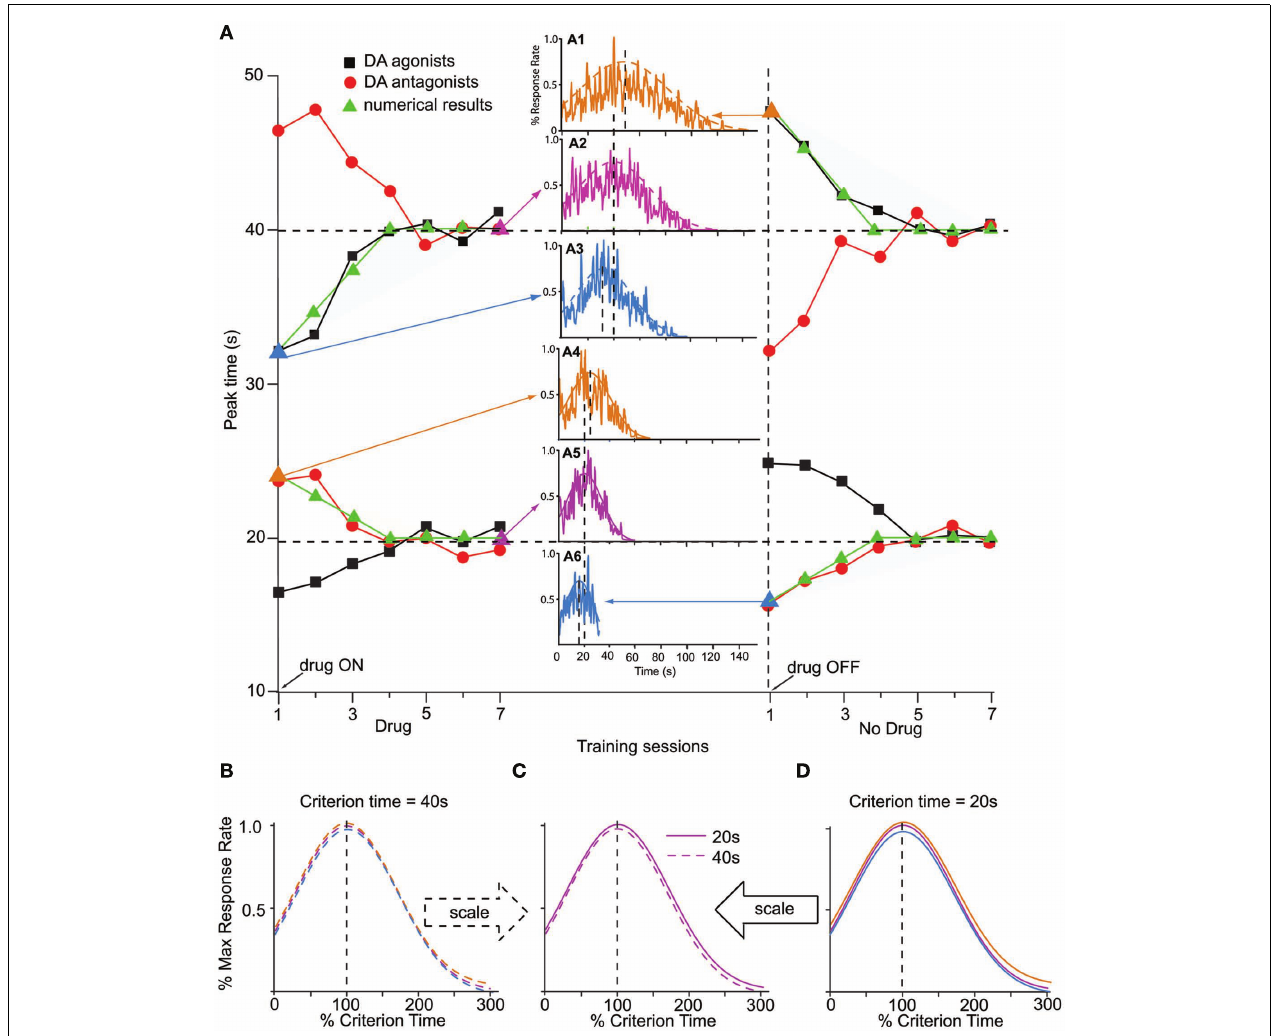
symbol of the color of the inset). Insets: A1: immediate rebound from T = 40 to T ∗∗ = 48s upon discontinuing methamphetamine; A2: recalibration under methamphetamine; A3: immediate shift under methamphetamine from T = 40 to T ∗ = 32s; A4: immediate shift under haloperidol from T = 20 to T ∗ = 24s; A5: recalibration under haloperidol; A6: immediate rebound upon discontinuing haloperidol.The dashed (A1–3) , respectively, continuous (A4–6) smooth lines represent Gaussian fits. (B) .The Gaussian fits (dashed smooth lines) in (A1–3) are given by Gauss (48, 31s), Gauss (40, 27s), respectively, Gauss (32, 21s).Timing functions at different points of the clock pattern for T = 40s are time-scale invariant. (C) .Timing functions from the 20-s clock pattern and 40-s clock pattern are time-scale invariant. (D) .The Gaussian fits (continuous smooth lines) in (A4–6) are given by Gauss (24, 16s), Gauss (20, 13s), respectively, Gauss (16, 11s).Timing functions at different points of the clock pattern for T = 20s are time-scale invariant. Colors match the insets. All Gaussian fits of numerical simulations gave COD > 0.9 and p <